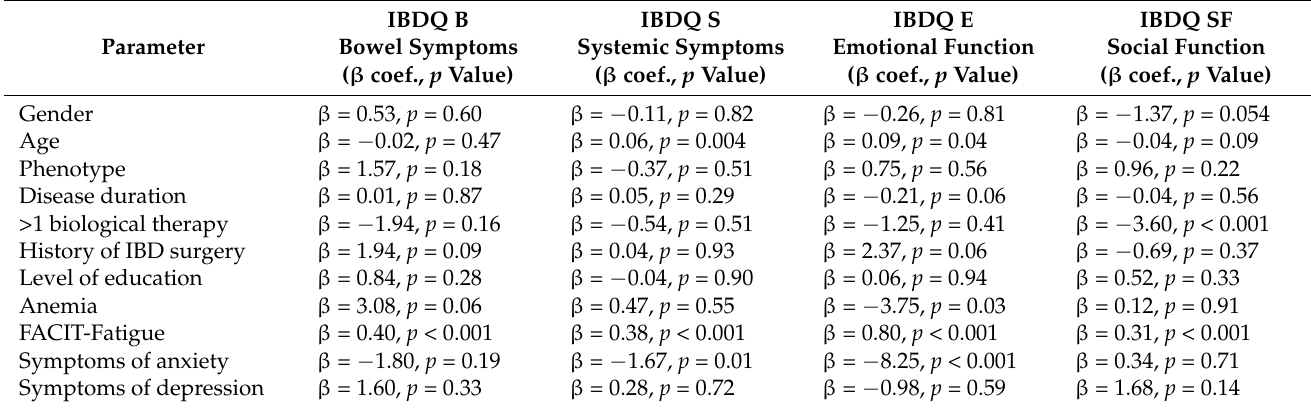
Table 3. Subanalysis of factors that lower the score of each domain of IBDQ32